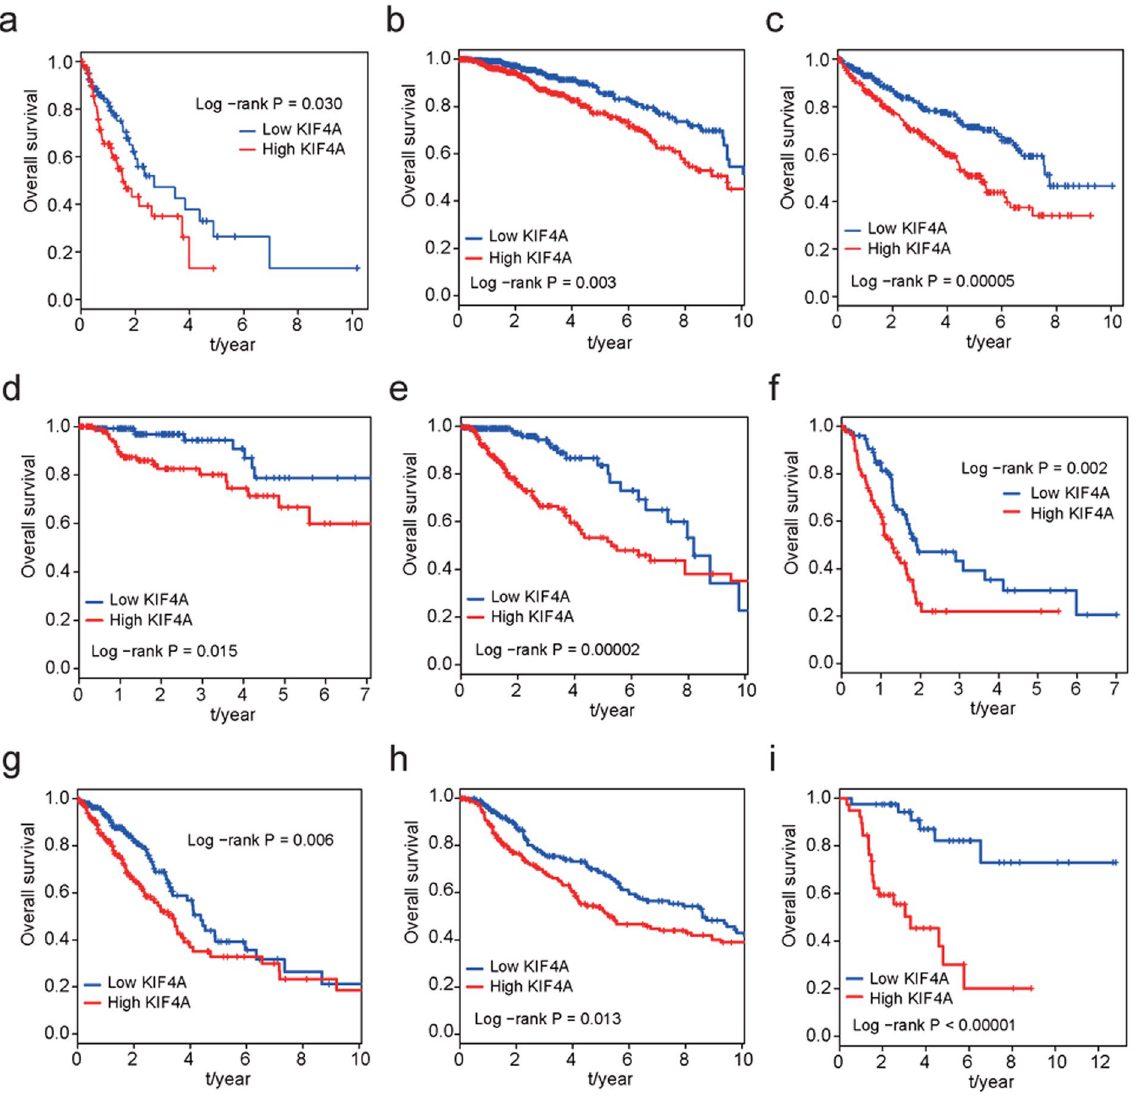
Figure 4. Prognosis effect of KIF4A expression level on overall survival in other human cancer types. ( a ) Esophageal carcinoma, ( b ) Breast cancer, ( c ) Kidney renal clear cell carcinoma, ( d ) Kidney renal papillary